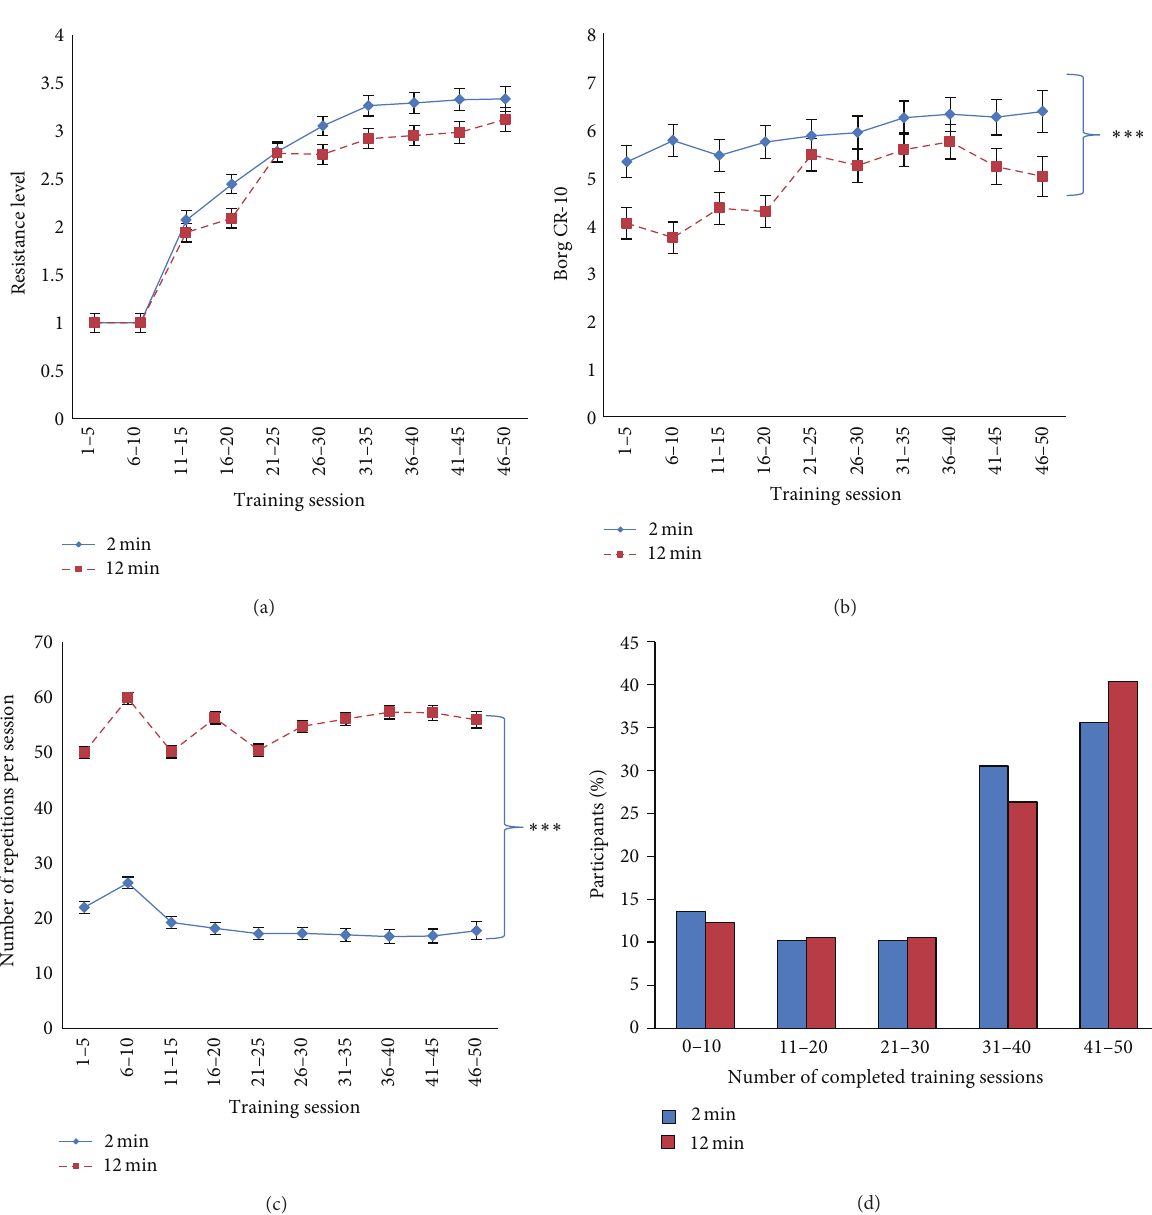
Type of Training (Figures 3(a) and 3(b)). Participants of each group were also asked whether the type of training